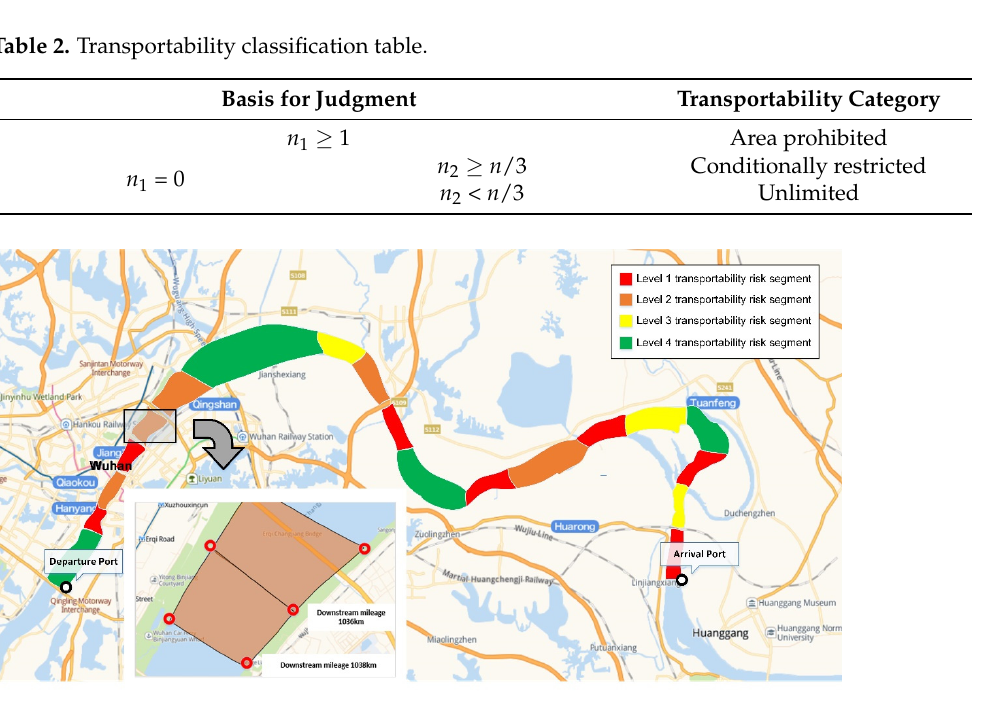
Figure 6. The schematic diagram of transportability assessment.